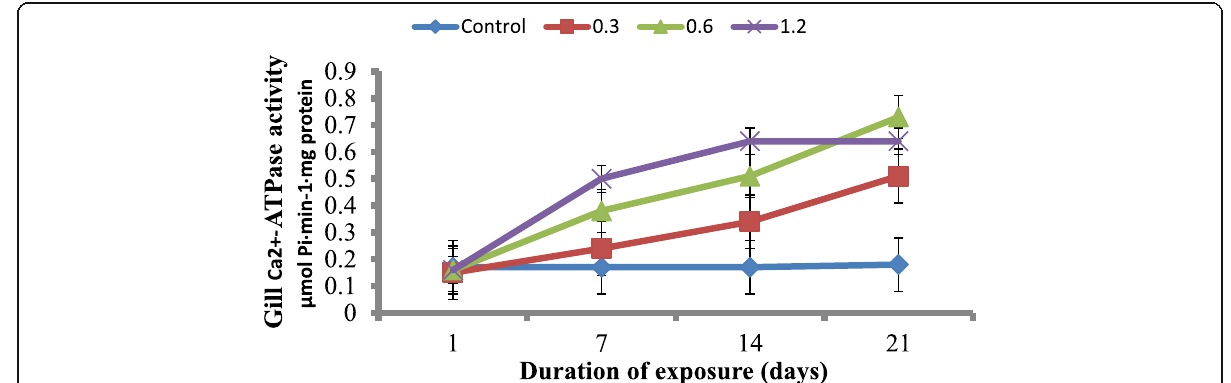
Fig. 1 Changes in gill Ca 2+ -ATPase activity in Clarias gariepinus juvenile exposed to oxadiazon (mean ±